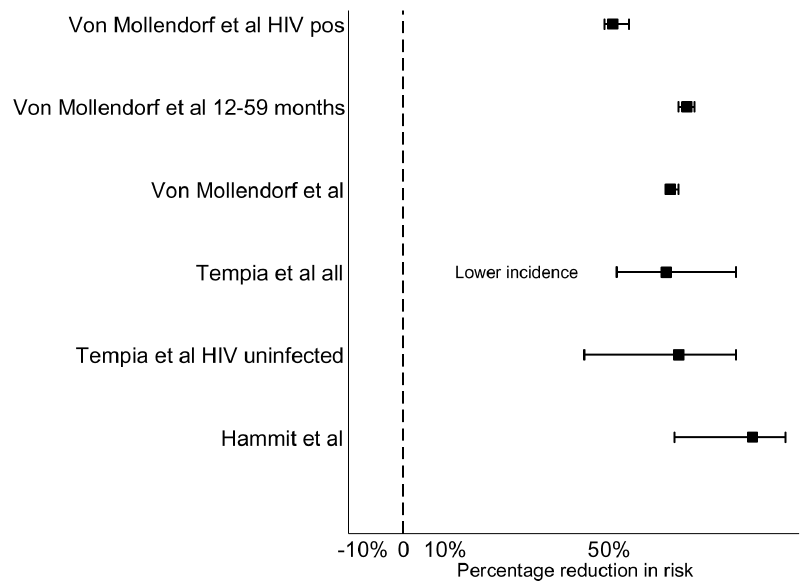
Figure 3. Forest plot showing the percentage risk reduction in pneumococcal pneumonia incidence in included studies and